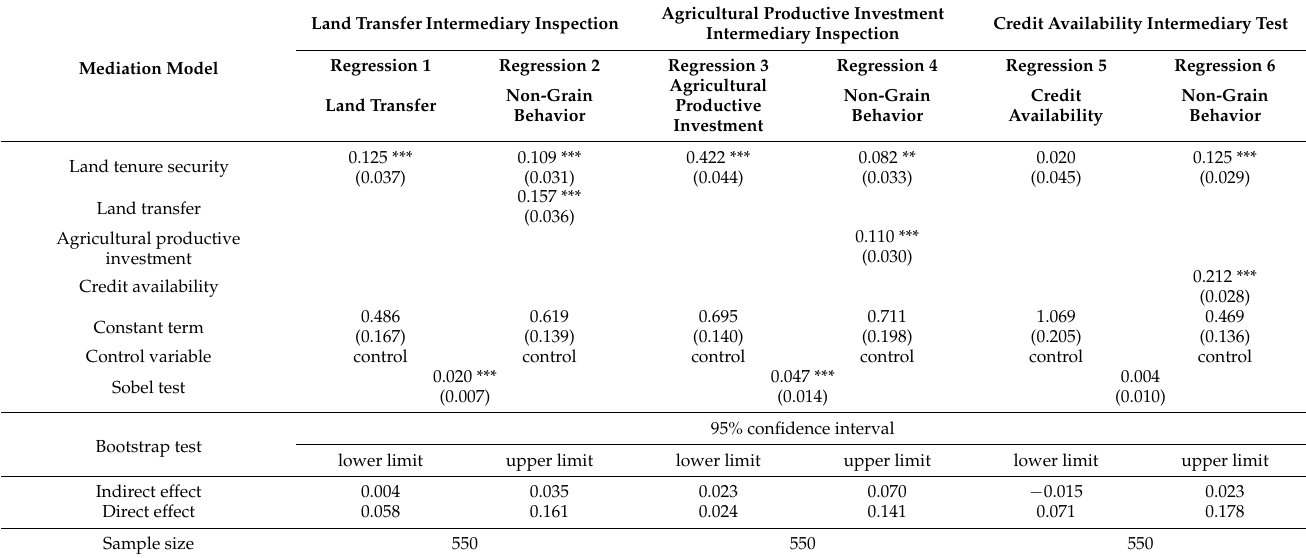
Table 4. Mechanism of action